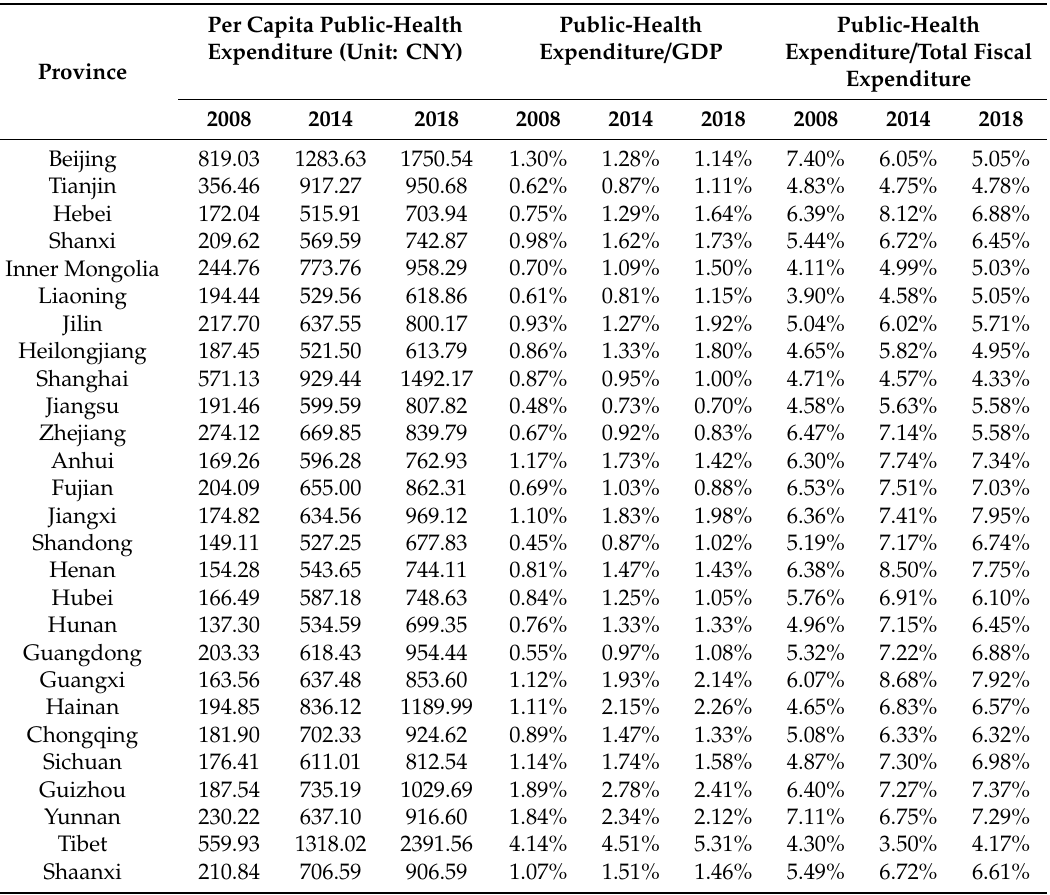
Table 2. Chinese public-health expenditure at provincial